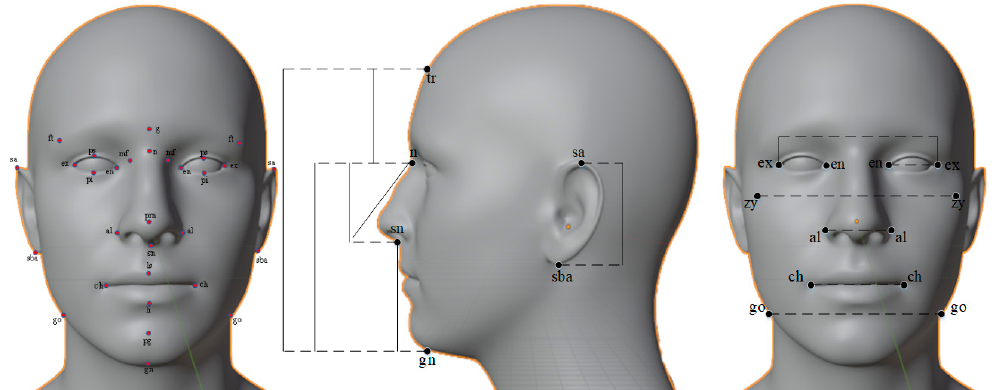
Figure 1. Depicting the location of landmarks on the human face presented in the reviewed studies based on Farkas Atlases [30,34].